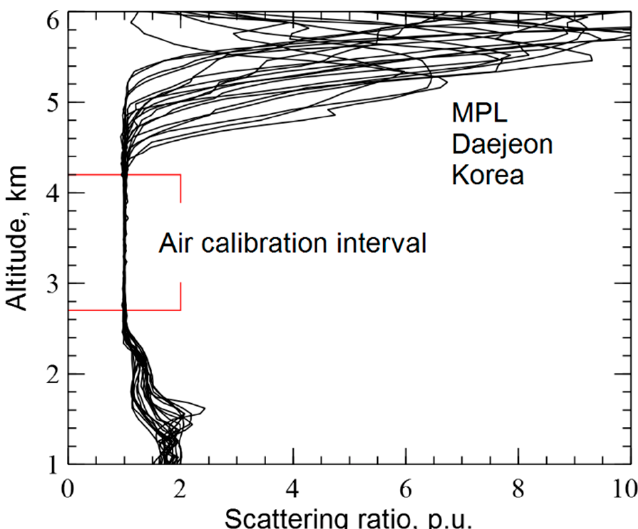
Figure 5. Vertical profiles of the scattering ratio. The boundaries of the MPL calibration range are indicated in red. MPL, Daejeon, Republic of Korea.